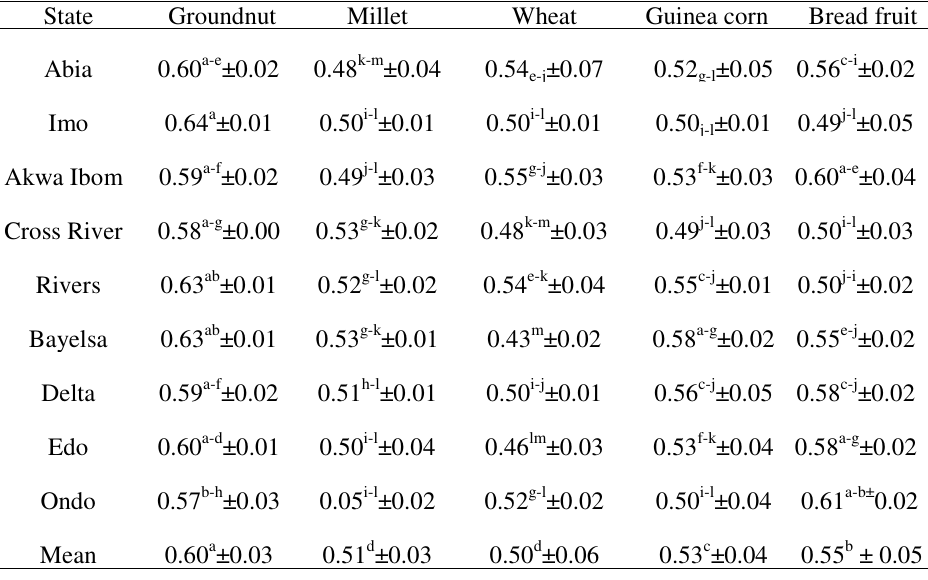
Table 4 . Tannins content of grains,